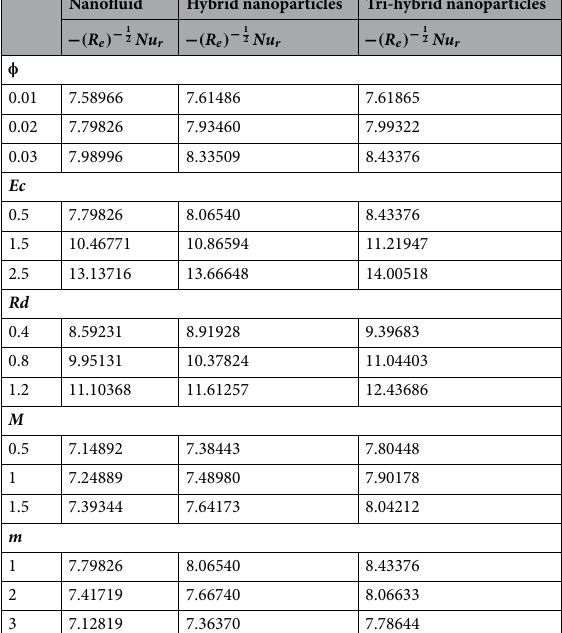
Table 4. Simulation of comparisons between tri-HNFs, HNFs and NF of Nusselt